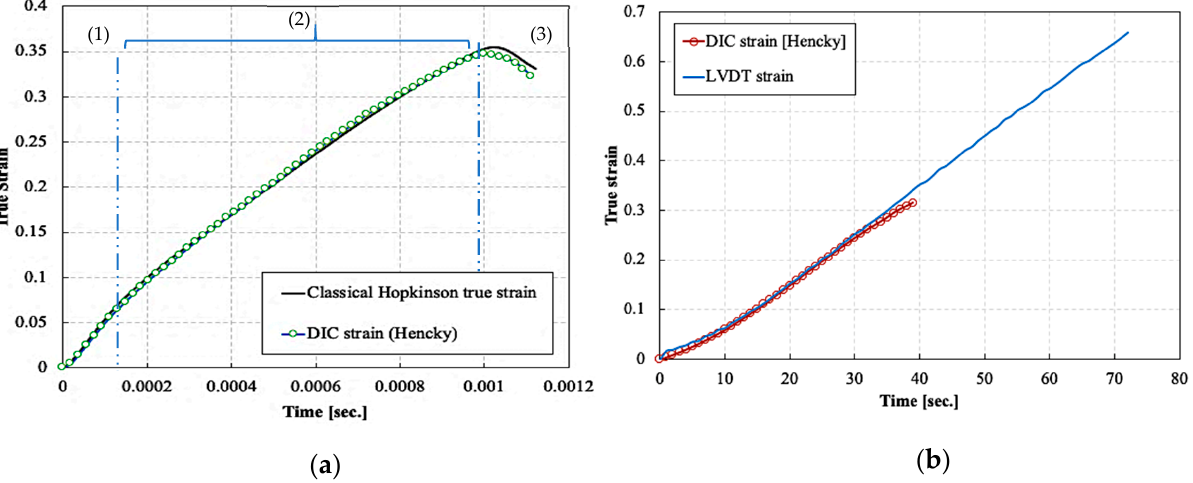
Figure 8. Strain-time history: ( a ) during a high strain rate compression experiment, ( b ) during a quasi-static strain compression experiment.